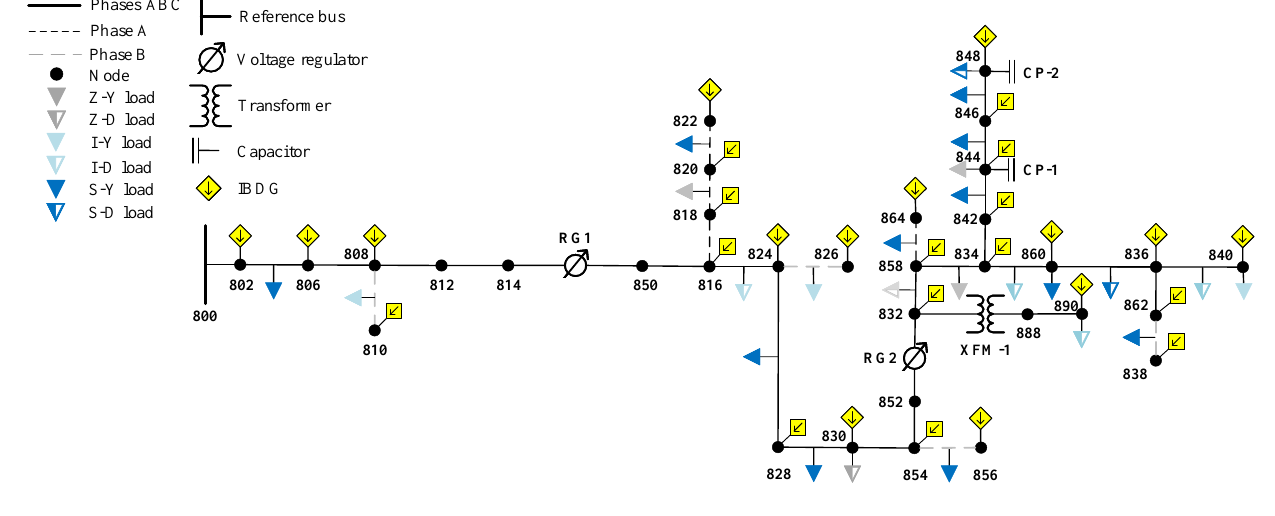
Figure 6. Representation of the IEEE 34-Node Radial Distribution Test